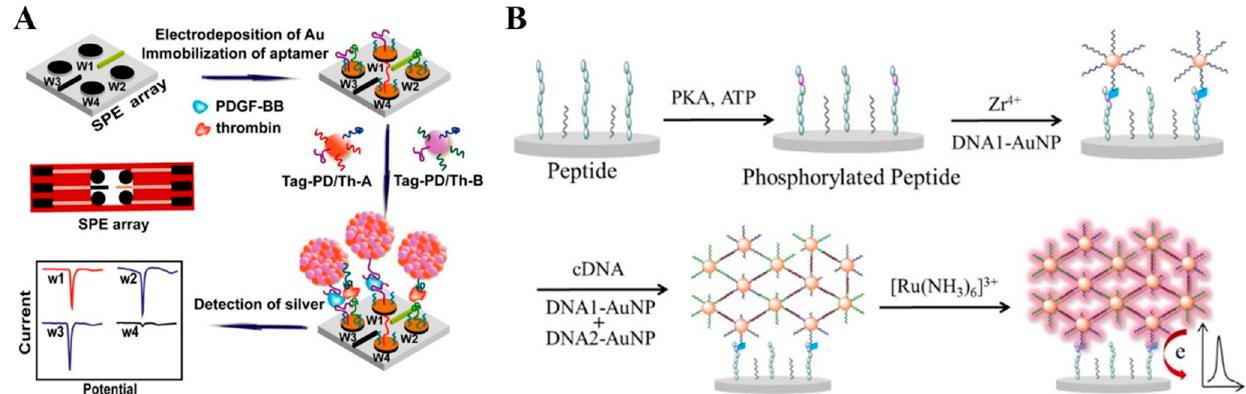
Figure 1. ( A ) Schematic representation of the principle of the dnGOPs-based electrochemical detection of DNA [37]. Copyright 2014 American Chemical Society. ( B ) Schematic representation of DNA-AuNPs assembled polymeric network amplified electrochemical biosensor for kinase activity detection [38]. Copyright 2014 American Chemical Society.